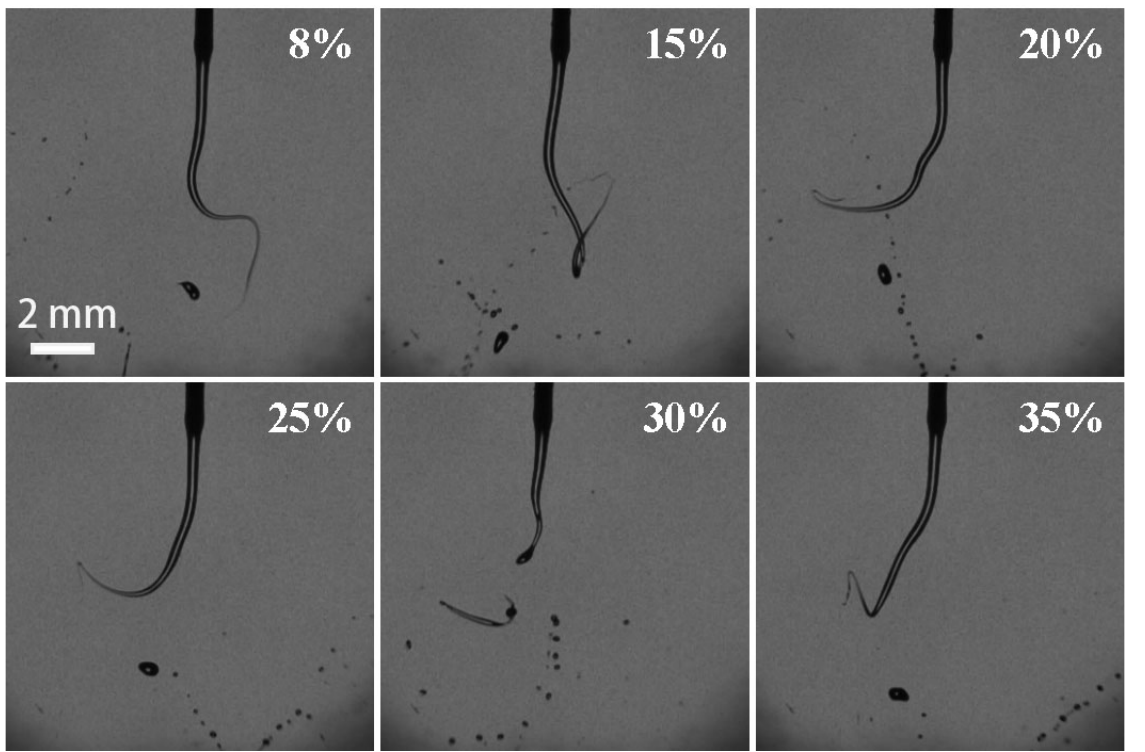
Figure 12. Pictures of electrostatic breakup of H 2 O 2 ligaments and droplet formation at different H 2 O 2 concentrations (21G nozzle, flow rate of 500 mL/h, voltage of 28